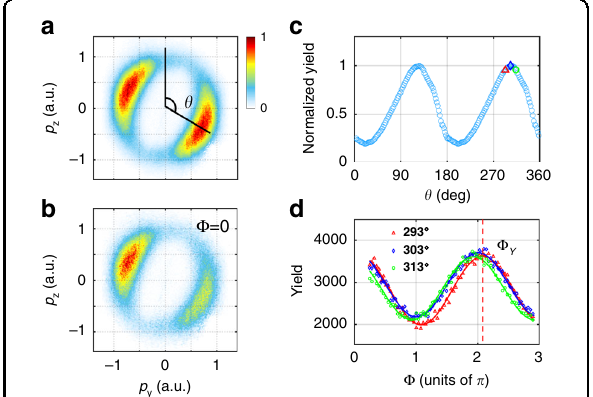
Fig. 2 Measured PMDs and electron yields. The measured PMDs in the polarization plane ( a ) for an average of all relative phases and ( b ) for the relative phase of zero. The electron emission angle θ is de fi ned between the electron emission direction relative to the major axis of the elliptically polarized laser fi eld. c The radially integrated PAD of ( a ). d The electron yield as a function of the relative phase for three emission angles (293°, 303°, and 313°) in angular bins of 1°. The solid lines in ( d ) are the fi t of the experimental data. ΔΦ Y for the emission angle of 293° is indicated by the dashed vertical line